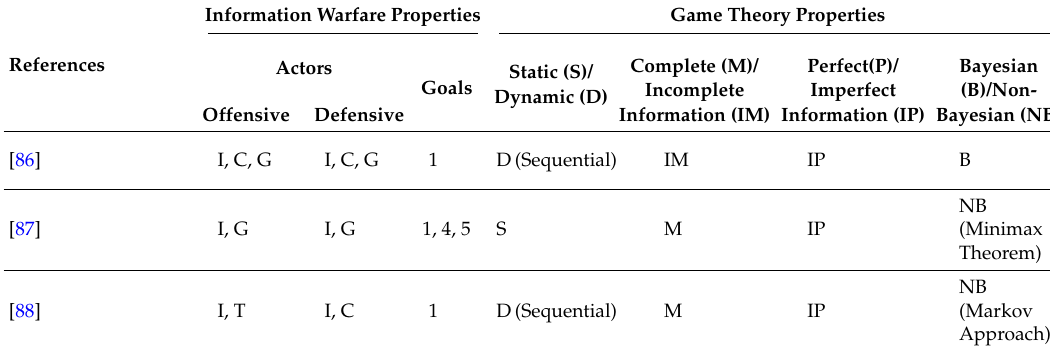
Table 9. List of Intelligence-based Warfare